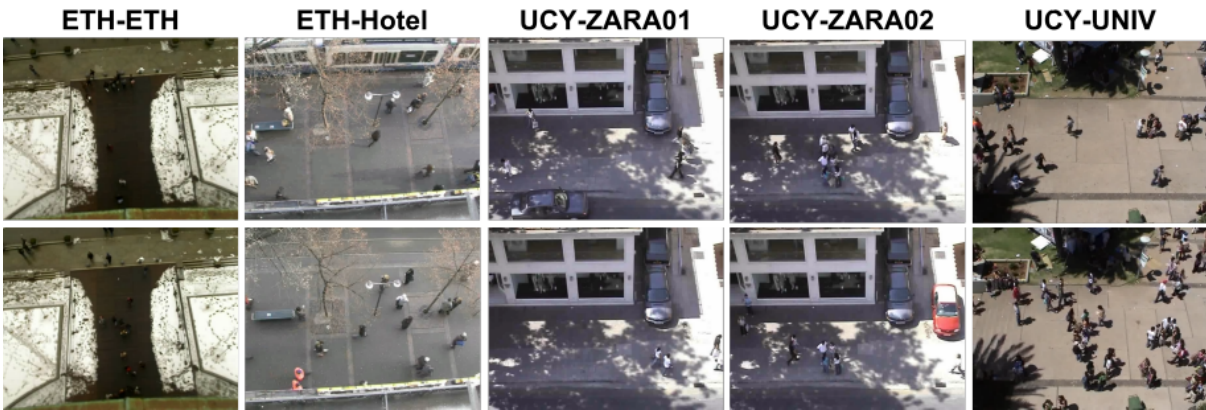
Figure 7. Examples of ETH and UCY